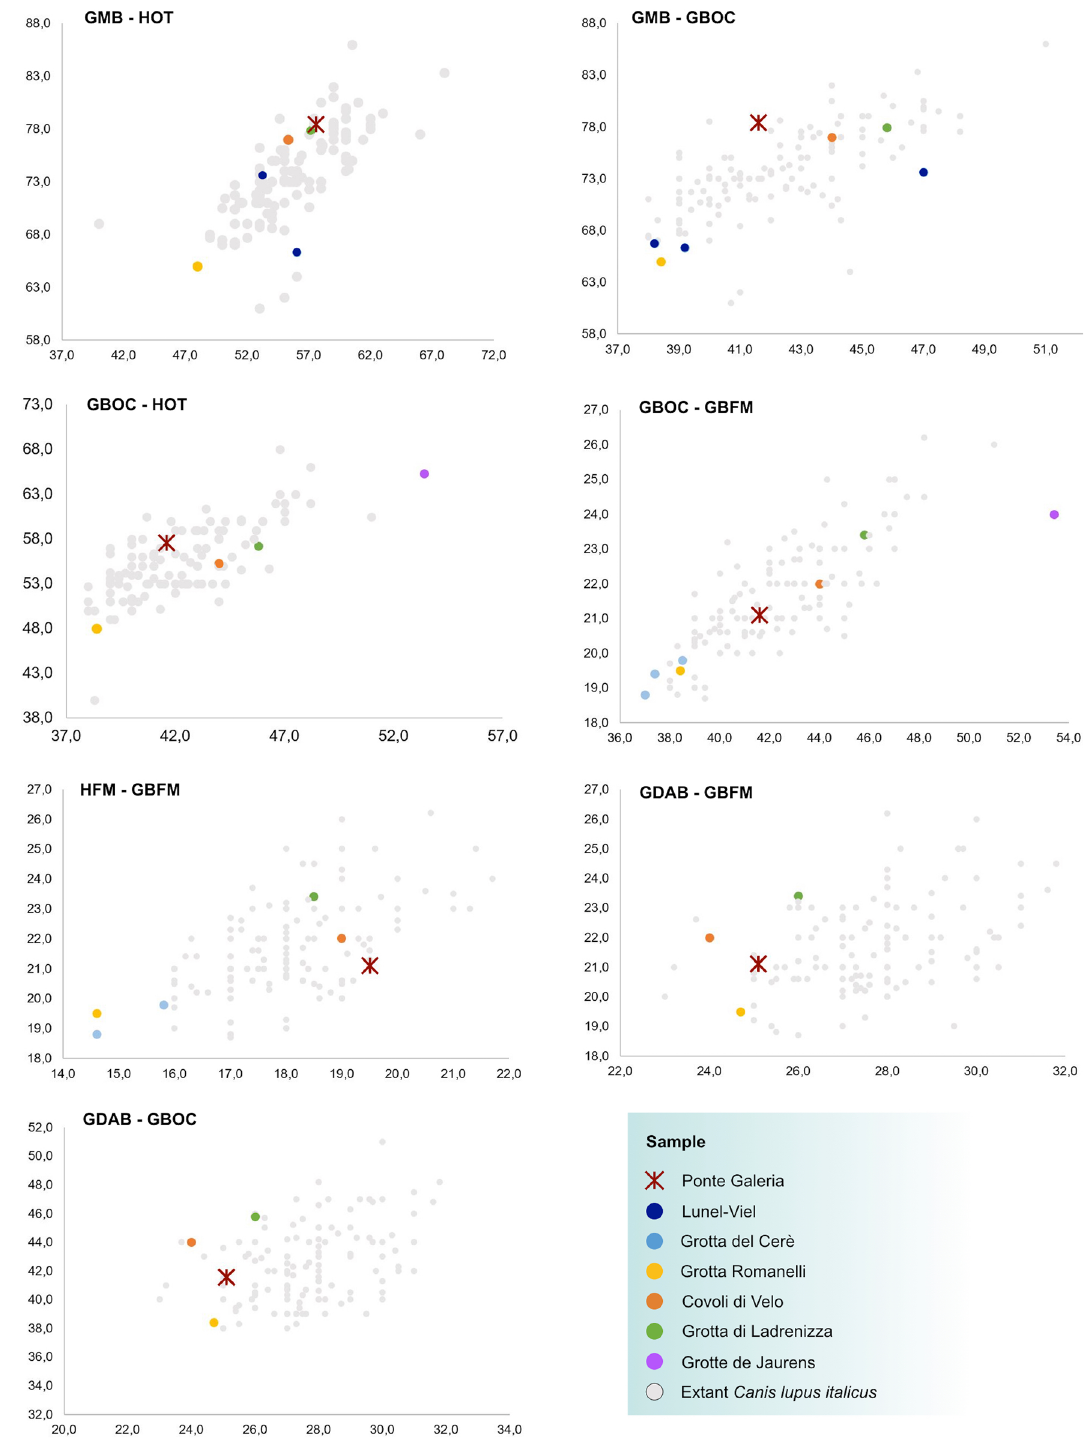
Figure 5. Bivariate plots of cranial measurements of fossil and extant canids. GDAB Greatest diameter of the auditory bulla, GMB Greatest mastoid breadth, GBOC Greatest breadth of the occipital condyles, GBFM Greatest breadth of the foramen magnum, HFM Height of the foramen magnum, HOT Height of the occipital triangle. Measurements are reported in Supplementary Table